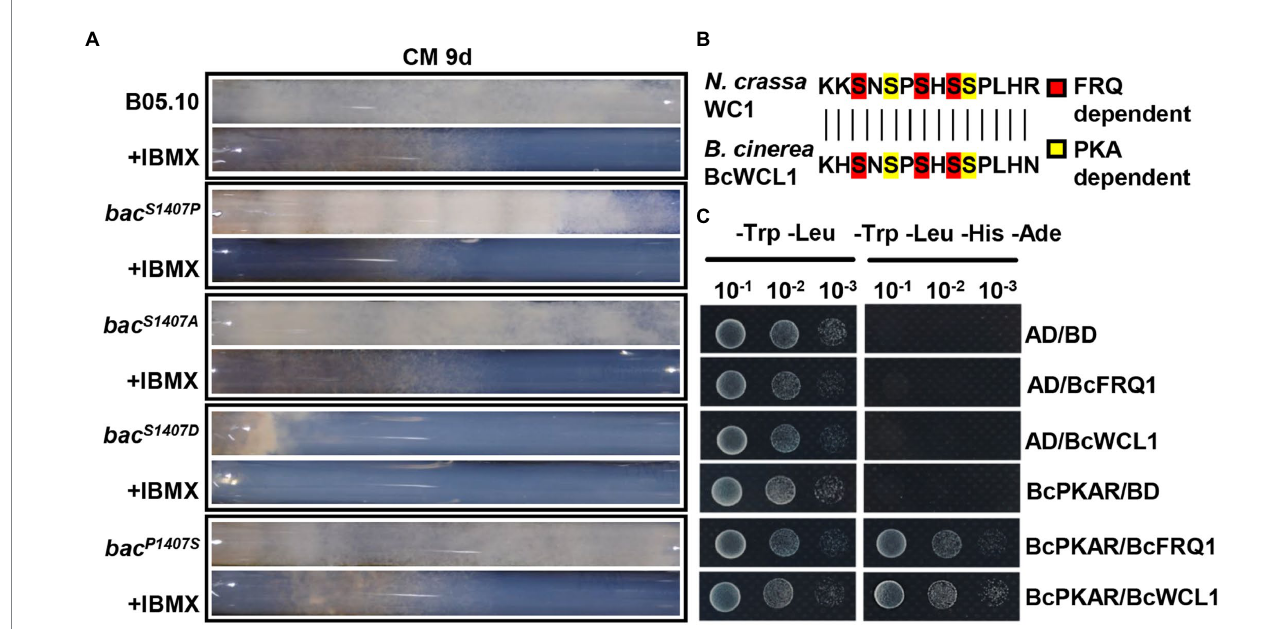
FIGURE 8 (A) Race tube assay for the same strains grown on CM media with or without IBMX at 9 days under LD conditions along with the circadian rhythms after incubation. (B) Comparison of amino acid sequences in phosphorylation sites between N. crassa WC1 and B. cinerea BcWCL. (C) Yeast two-hybrid analysis of BcPKAR, BcFRQ1, and BcWCL1. In this assay, yeast cells were used at various densities (10 − 1 to 10 − 3 conidia/ μ l dilution). AD and BD represent empty